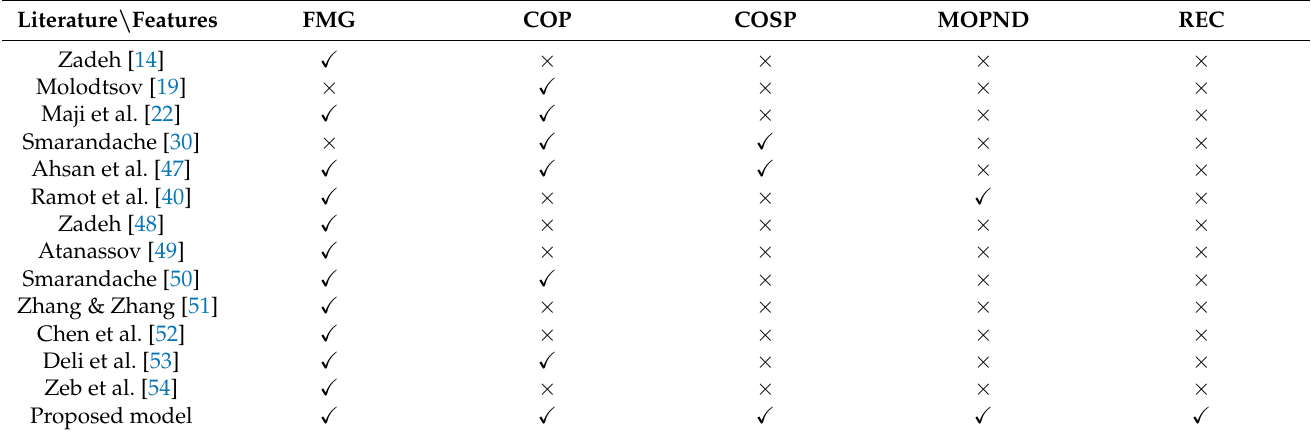
Table 19. The proposed C FH S is compared to established